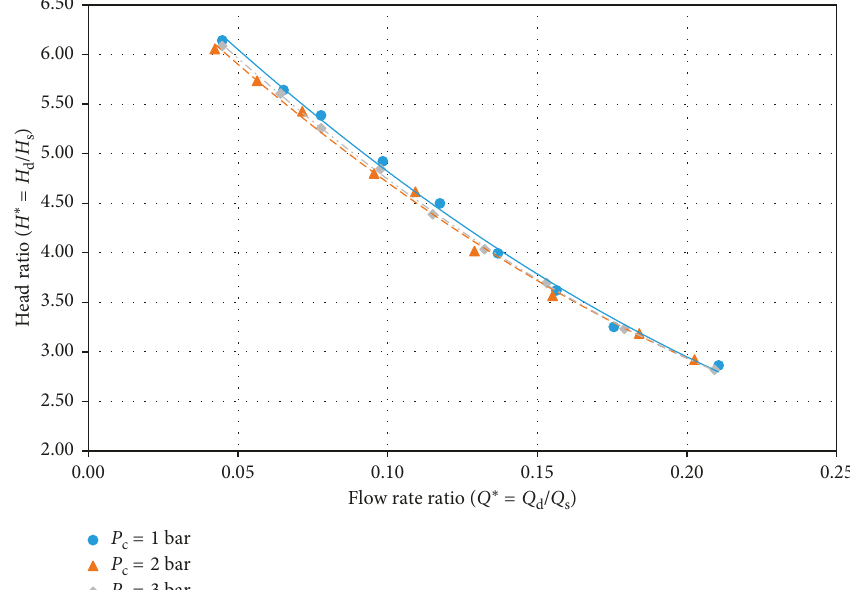
Figure 8: Head ratio vs. flow-rate ratio at the pressure difference pressure inside the air chamber, P